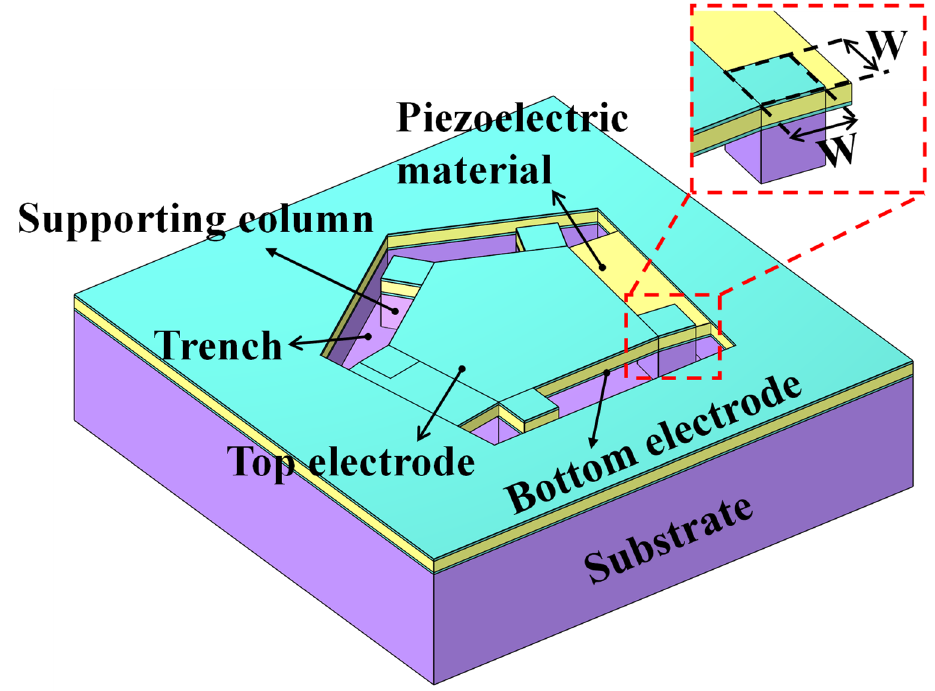
Figure 1. Sketch of the FBAR with supporting column structures.